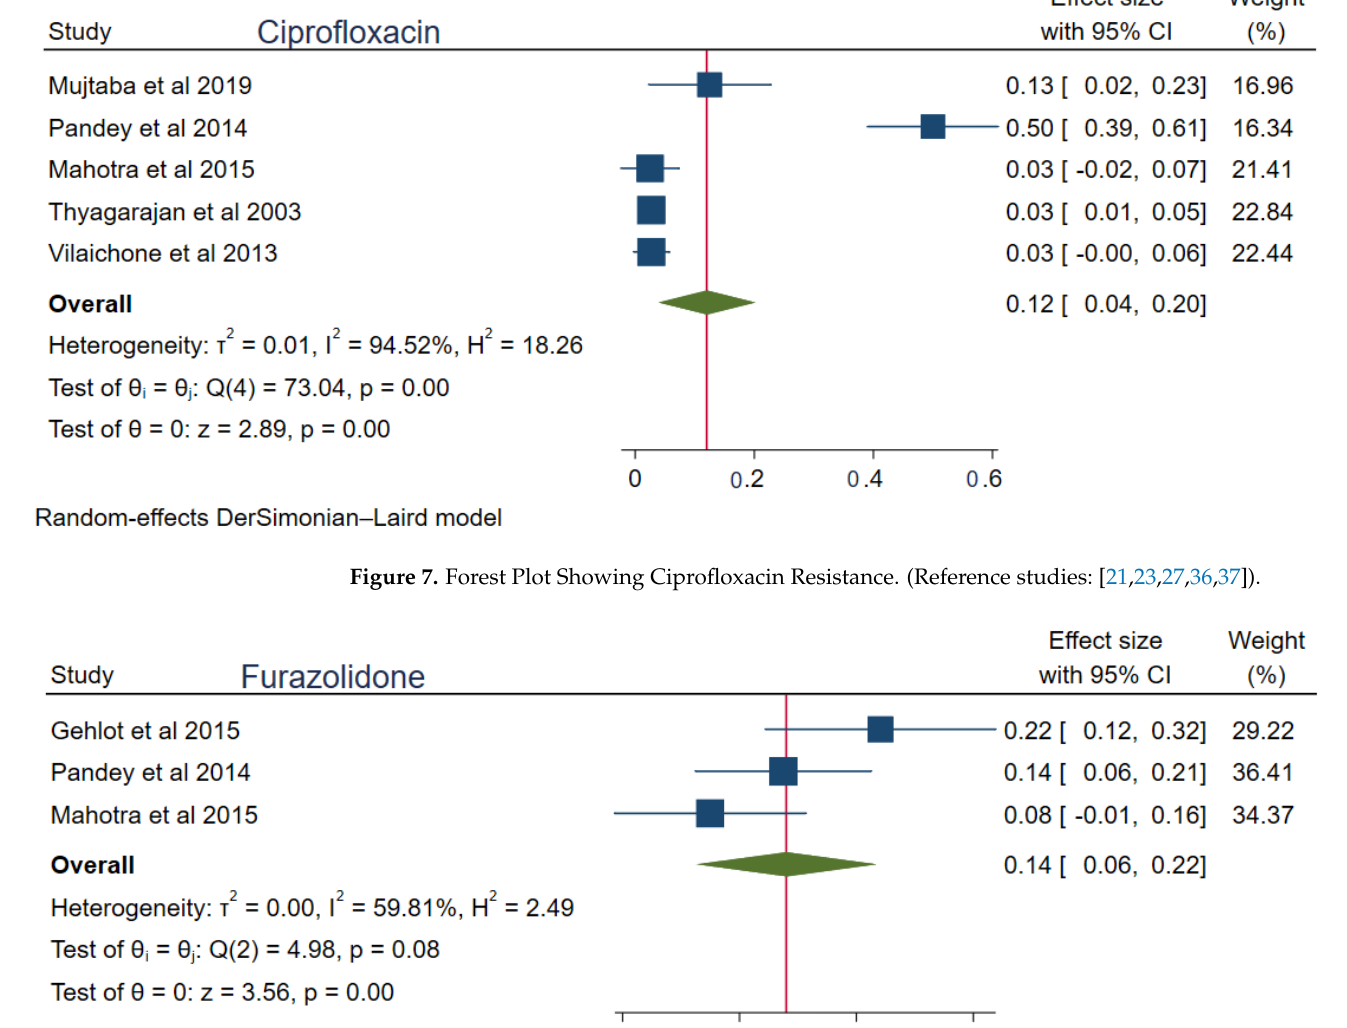
Figure 6. Forest Plot Showing Levofloxacin Resistance. (*: the same study with data from two countries, Reference studies: [14, 15, 20, 22, 26, 31, 34, 37, 38]